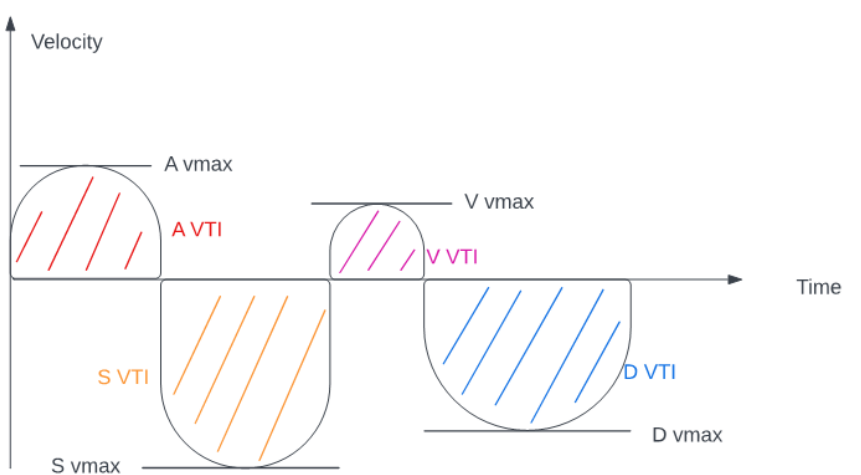
Figure 2. Hepatic venous flow (velocity-time integral and maximal velocity explanation).